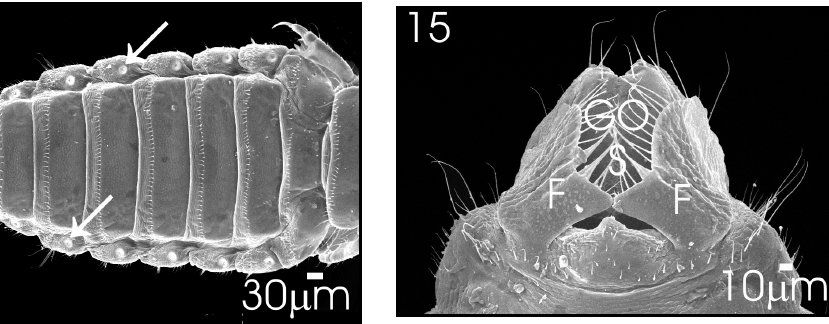
Fig. 12. A dorsal view of the abdomen showing 6 pairs of respiratory spiracles (arrows).